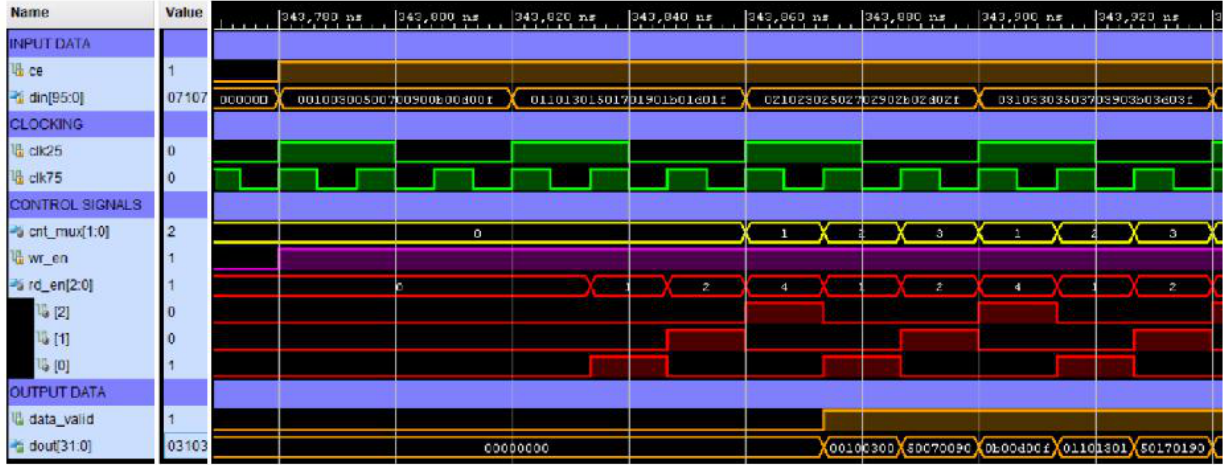
Figure 14. Simulation of the packer